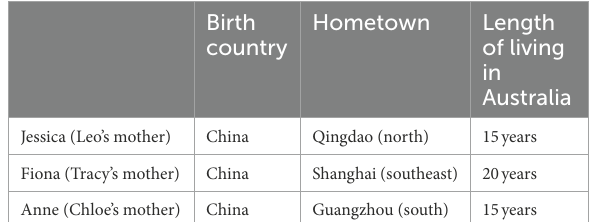
TABLE 2 Profile of the parent